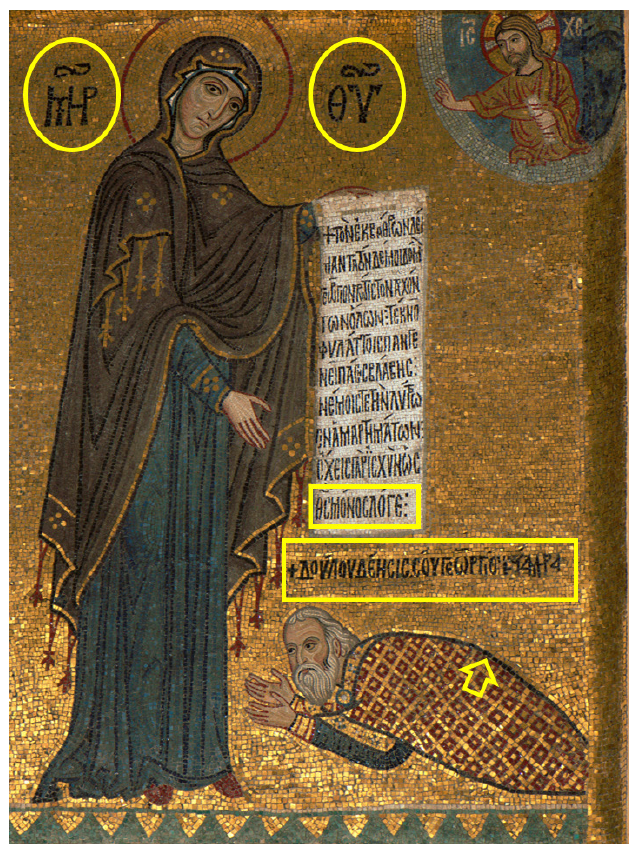
Figure 8: Palermo, St. Mary of the Admiral, Dedication panel: some areas with black tesserae in the mosaic wall (yellow areas).